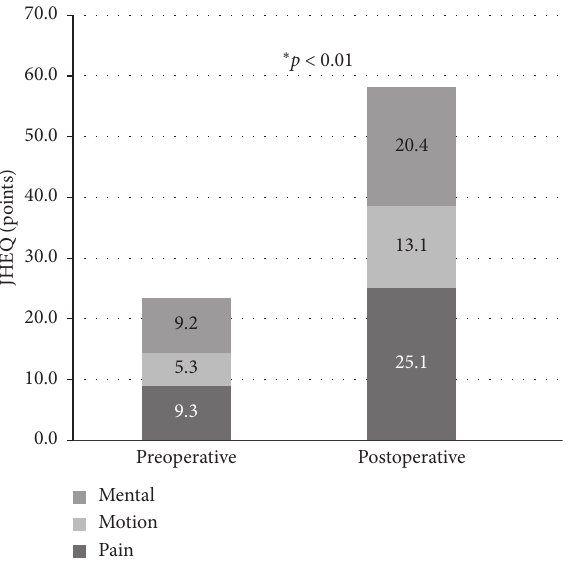
Figure 5: Preoperative and postoperative JHEQ scores. The JHEQ is significantly improved from the preoperative mean of 23.8 to the postoperative mean of 58.6 ( p � 0 . 6890, Wilcoxon rank sum